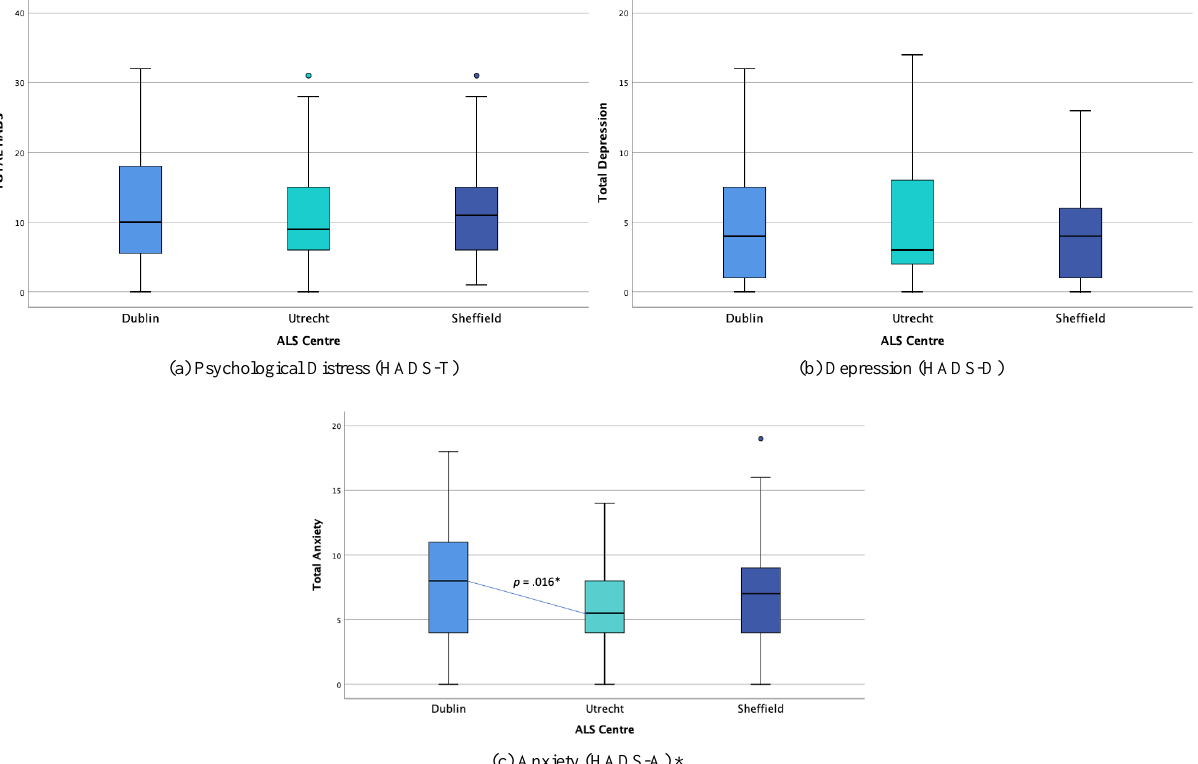
Figure 3. Distribution of psychological distress (HADS) scores across centres. * Statistical